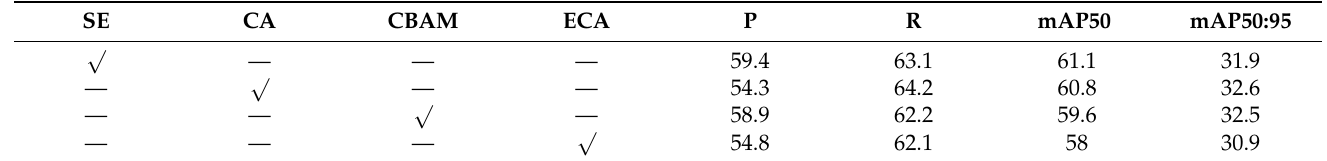
Table 4. Comparison of effects of different attention mechanisms in the ATPF module (NEU- CLS